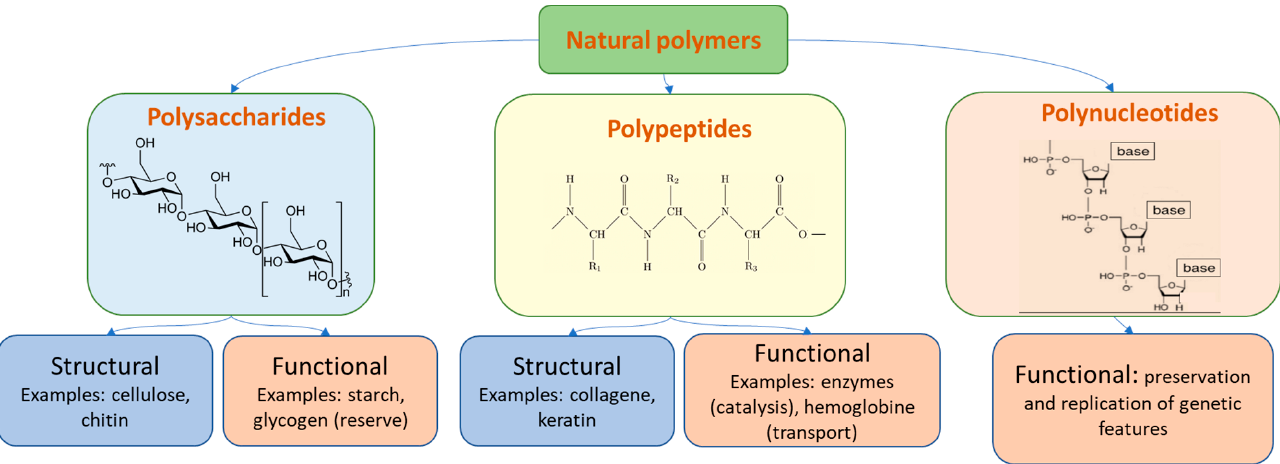
Figure 2. Scheme about the chemical structure of natural polymers and their main generical func- tions.